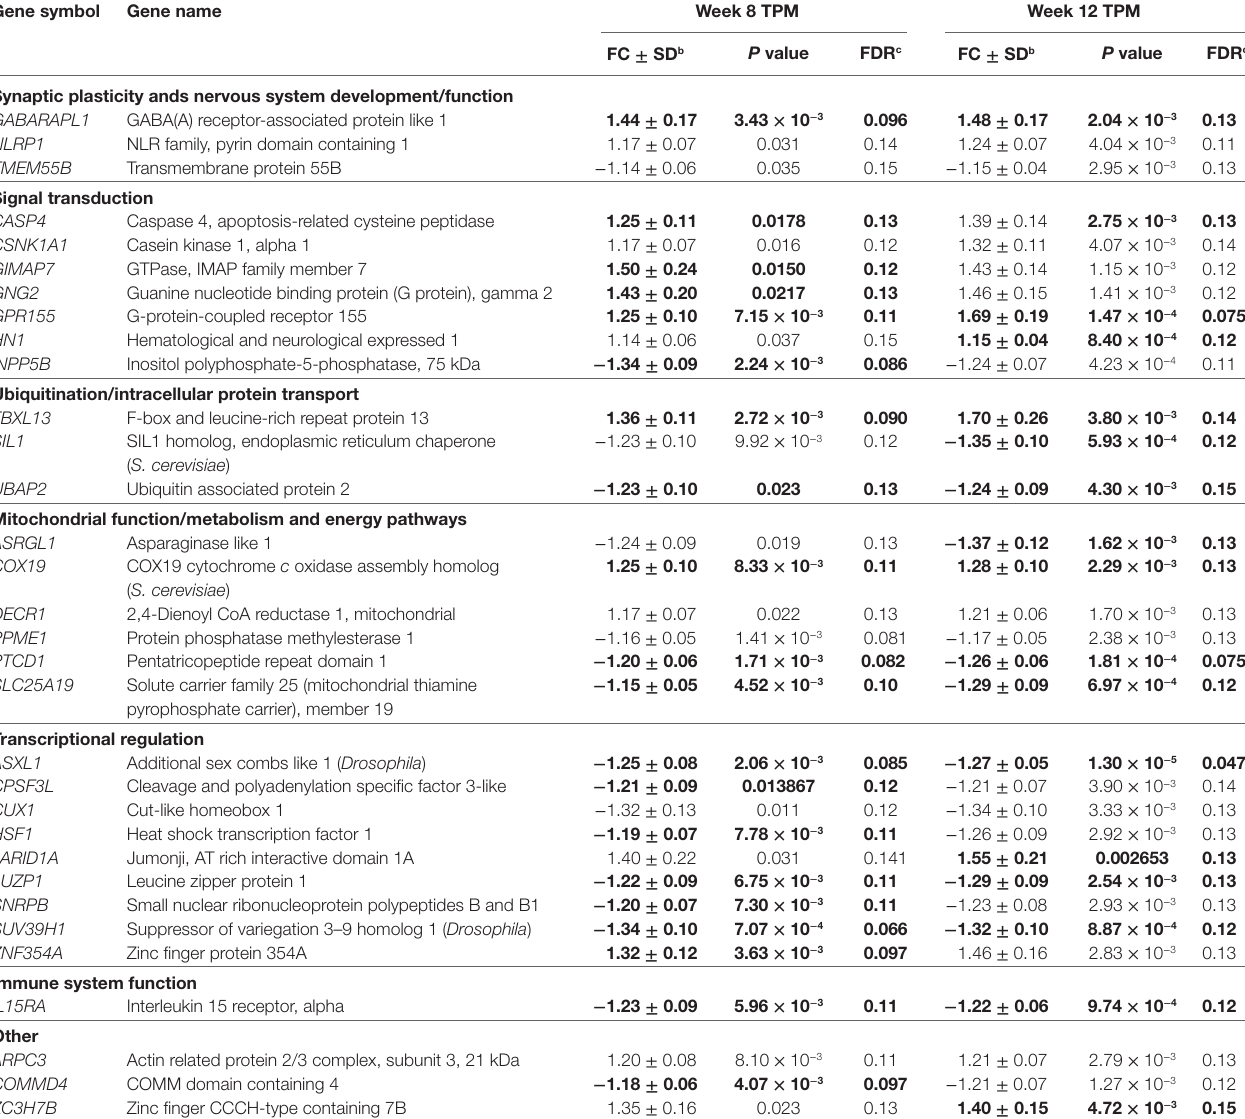
TaBle 2 | A list of 32 representative genes significantly and consistently modulated exclusively in weeks 8 and 12 topiramate (TPM) groups ( n = 32) based on secondary outcomes. a gene